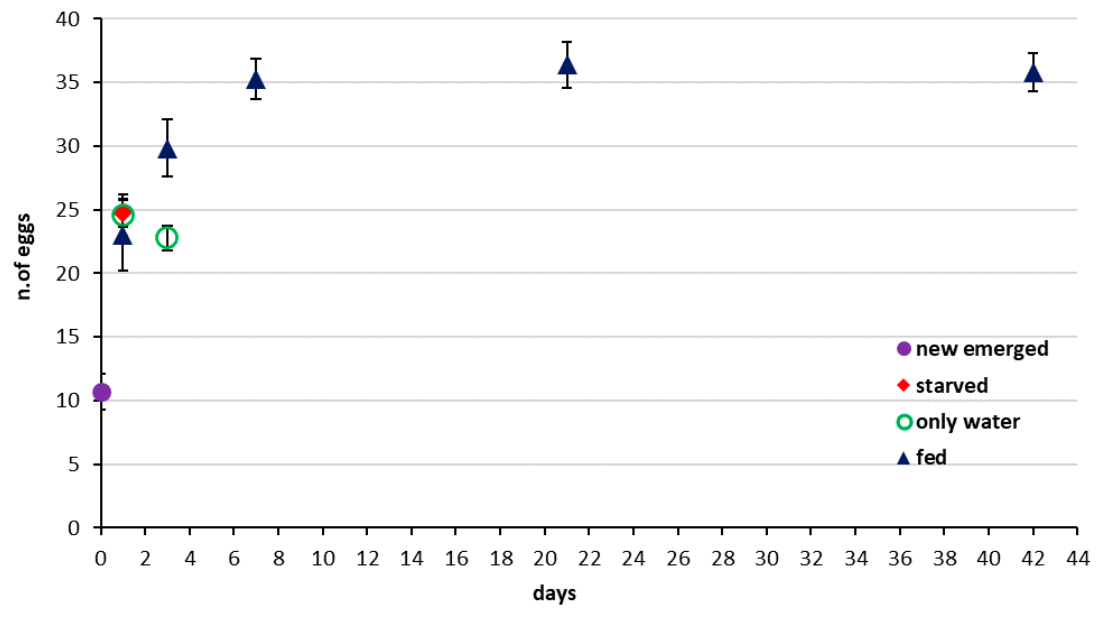
Figure 7. Trissolcus japonicus BIIRU colony: total number of mature eggs in the ovary at different time intervals in females with no oviposition opportunity (bars indicate S.E.).